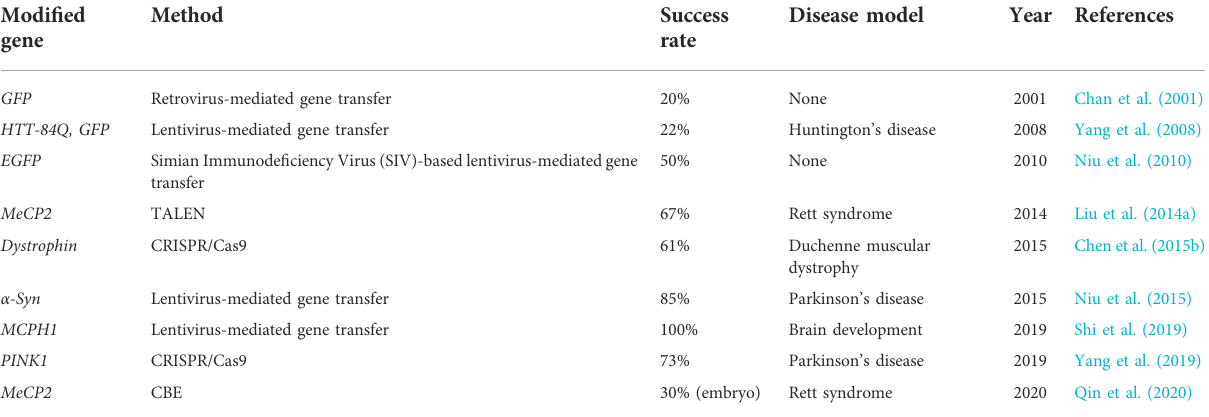
TABLE 1 Rhesus monkey models established by various gene editing